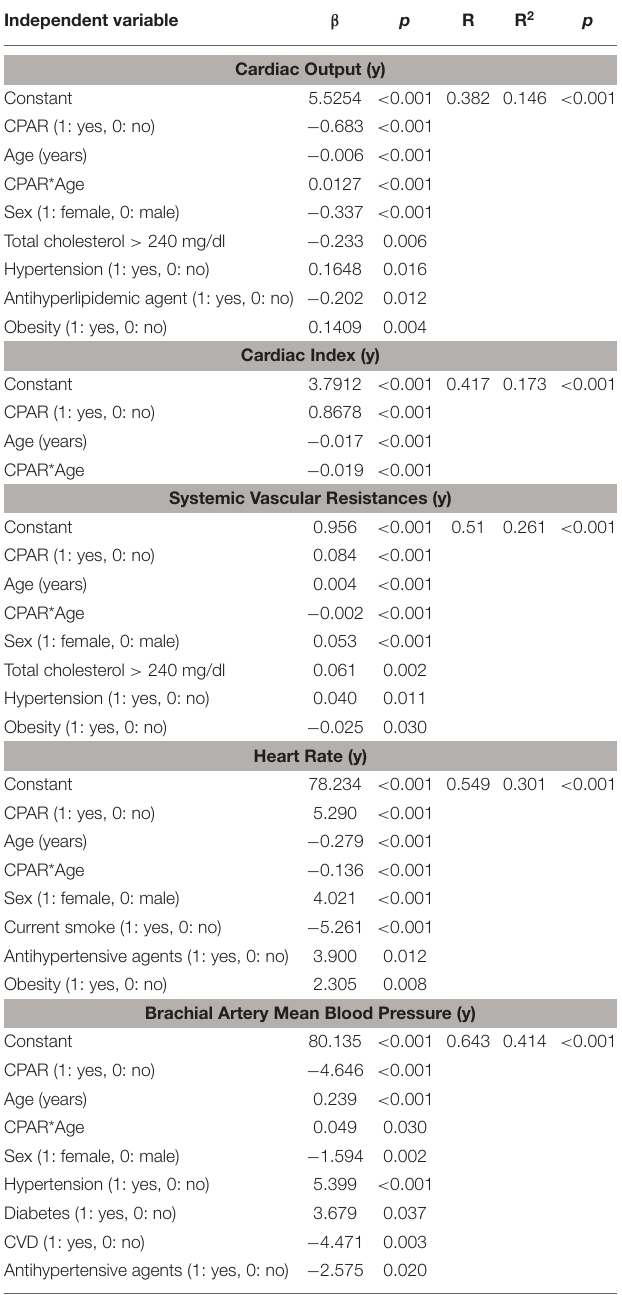
TABLE 3 | Independent association between CPARs and global hemodynamic indexes, with age as a moderating variable. Independent variable